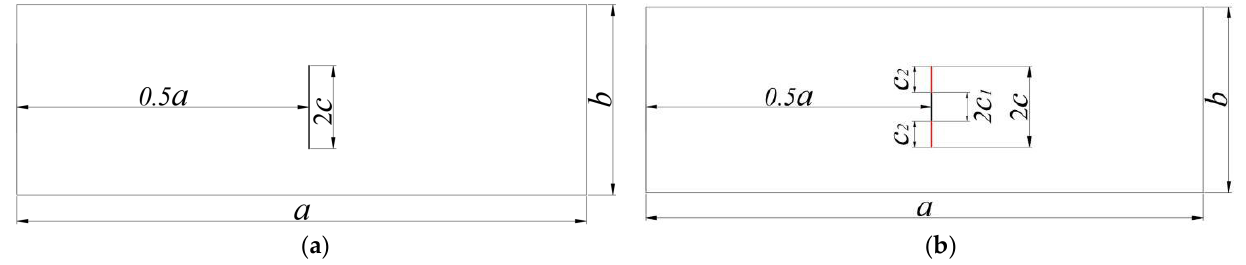
Figure 1. ( a ) plate with prefabricated crack; ( b ) plate with fatigue crack. Table 1. Geometry parameters of the cracked plate. Plate Length Plate Width